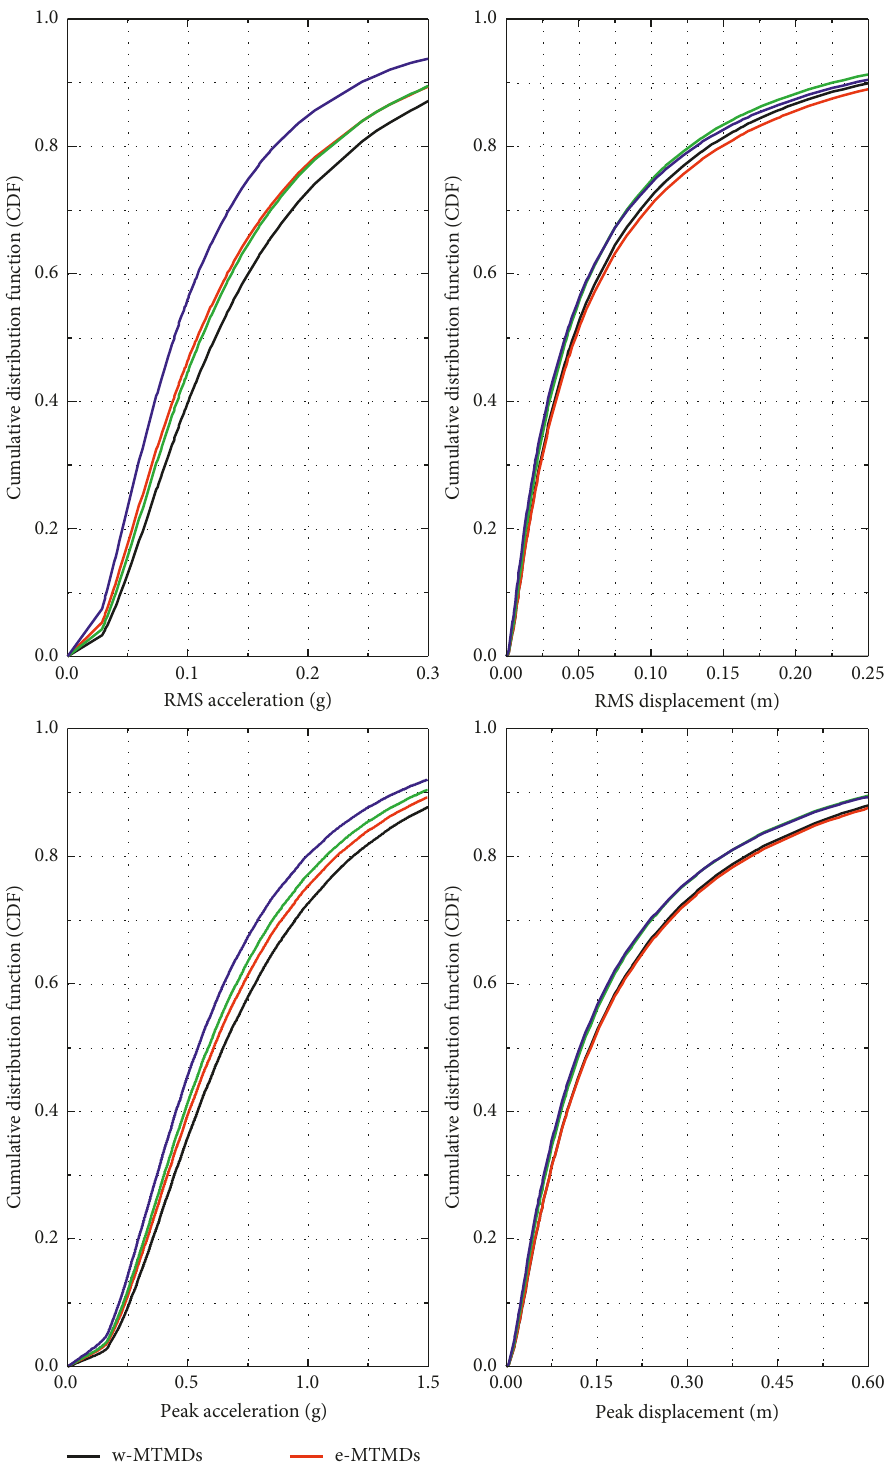
Figure 7: The CDF of responses for the w-MTMDs, e-MTMDs, wd-MTMDs, and ed-MTMDs subjected to earthquake